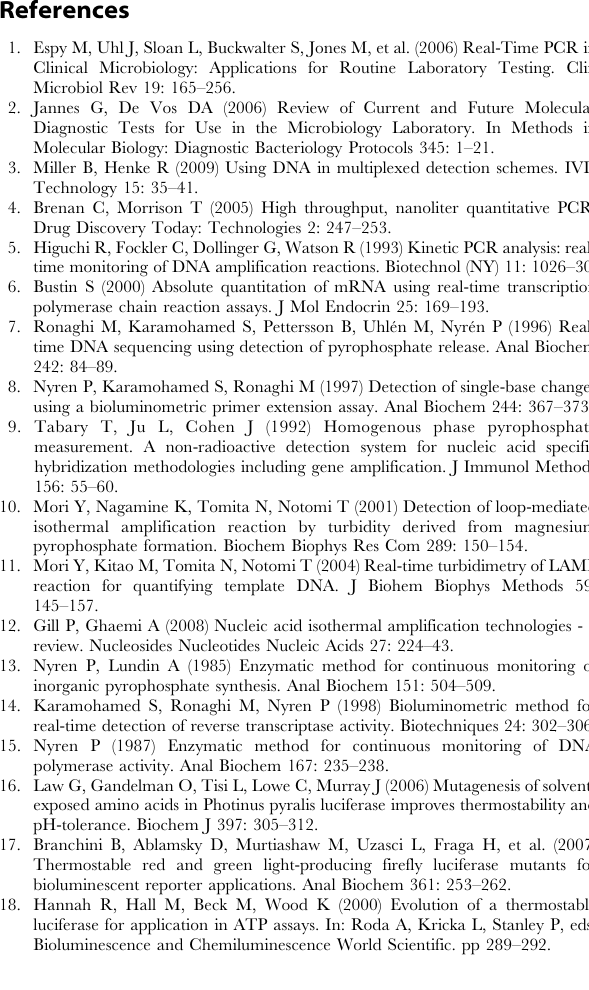
Table S2 Pathogenic bacteria and commensal organisms of the oropharynx and genital tract tested for